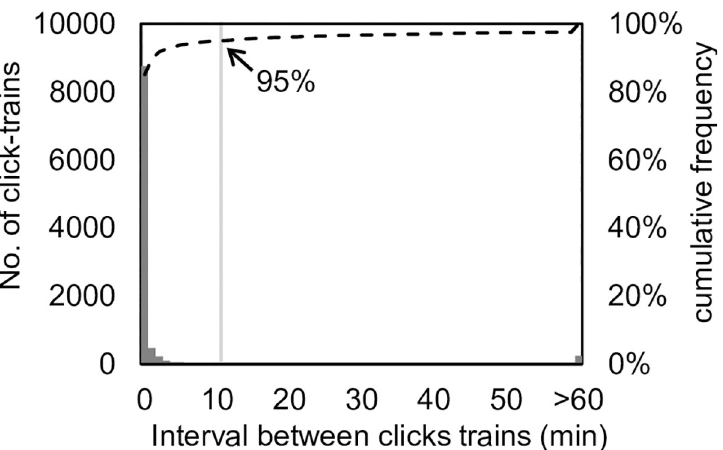
Fig 8. Frequency distribution of recorded intervals between click-trains of harbour porpoises recorded by the A- tags. The black bars show the number of click-trains at the corresponding interval between clicks-trains; the dashed line shows the cumulative distribution of the